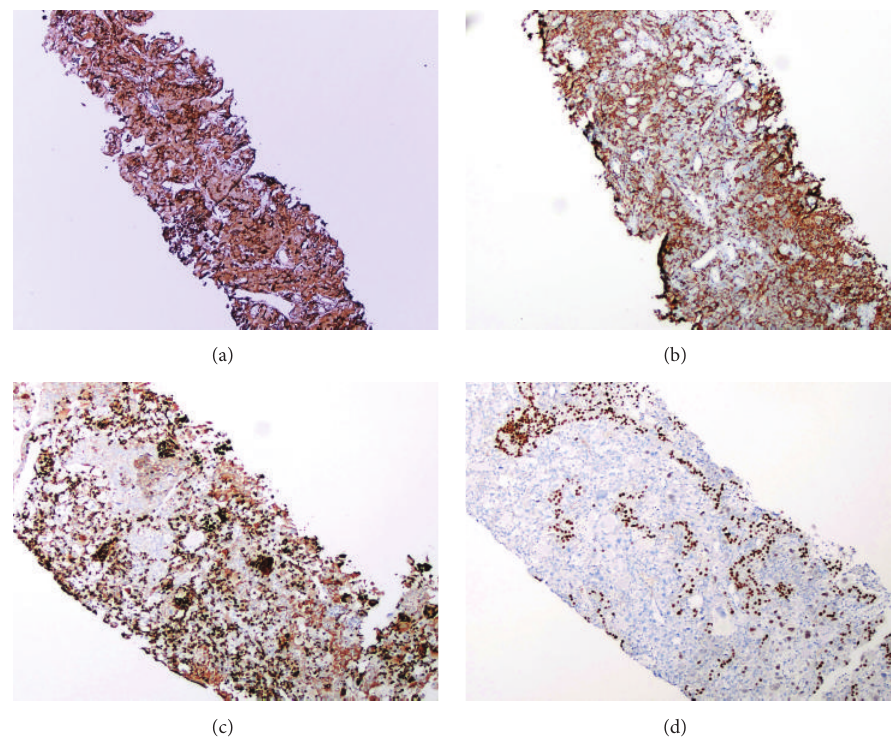
Figure 3: (a) Immunohistochemistry for CD68 highlights the tumor cells (100x). (b) Immunohistochemistry for lysozyme shows granular positivity in the cytoplasm of the tumor cells (100x). (c) Immunohistochemistry for HAM56 shows granular positivity in the cytoplasm of the tumor cells (100x). (d) Immunohistochemistry for PAX8 highlights the nuclei of renal tubular epithelial cells